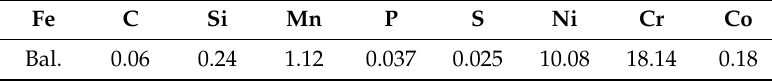
Figure 1. Schematic of Joule heating diffusion bonding.